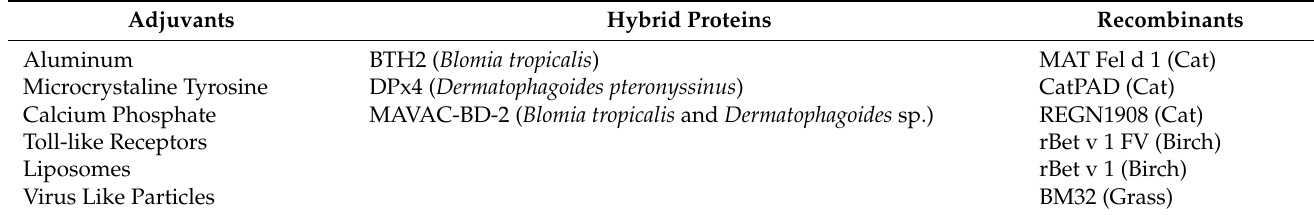
Table 1. Examples of new immunotherapy